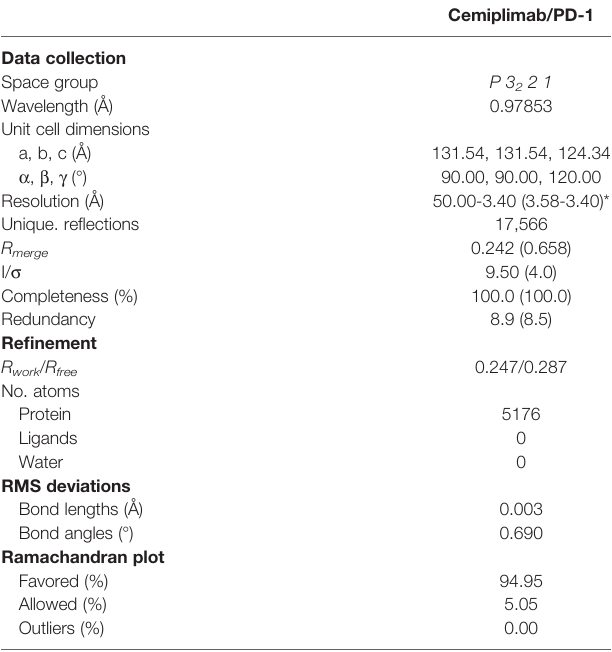
TABLE 1 | Crystallographic data collection and re fi nement statistics.